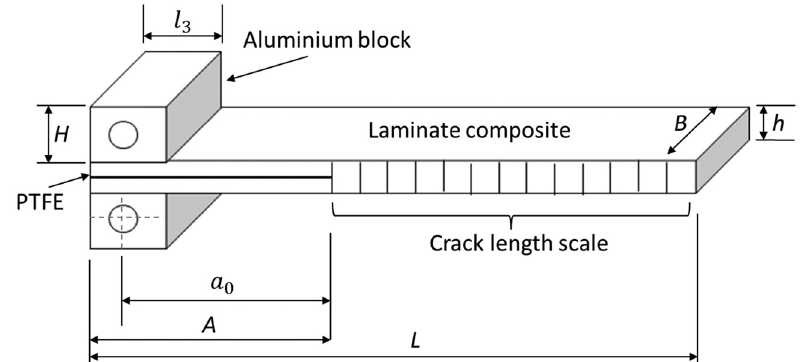
Figure 4: The sample dimension for DCB test.